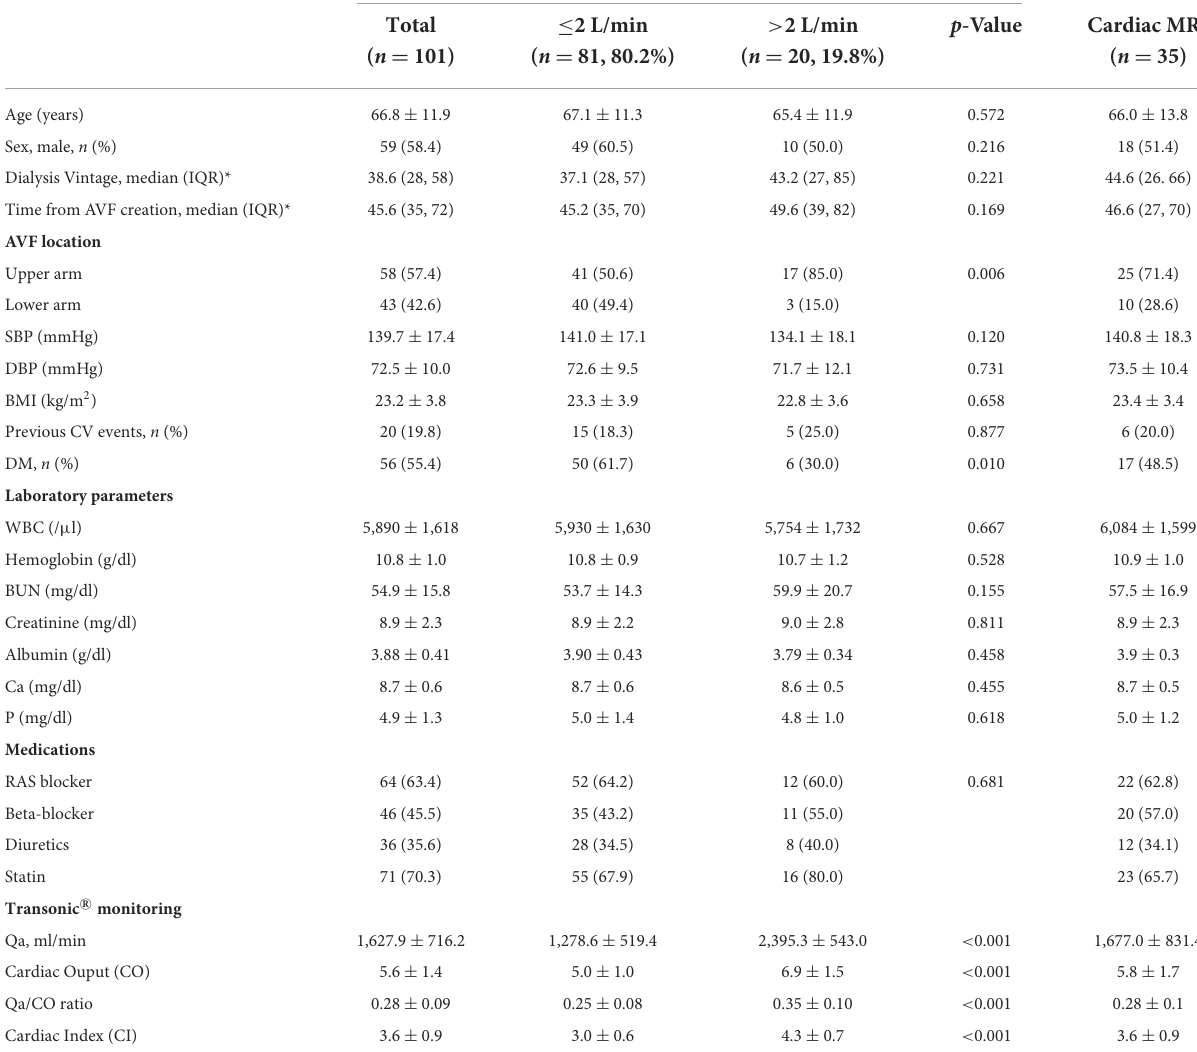
TABLE 1 Baseline clinical and biochemical data according to the intra-access